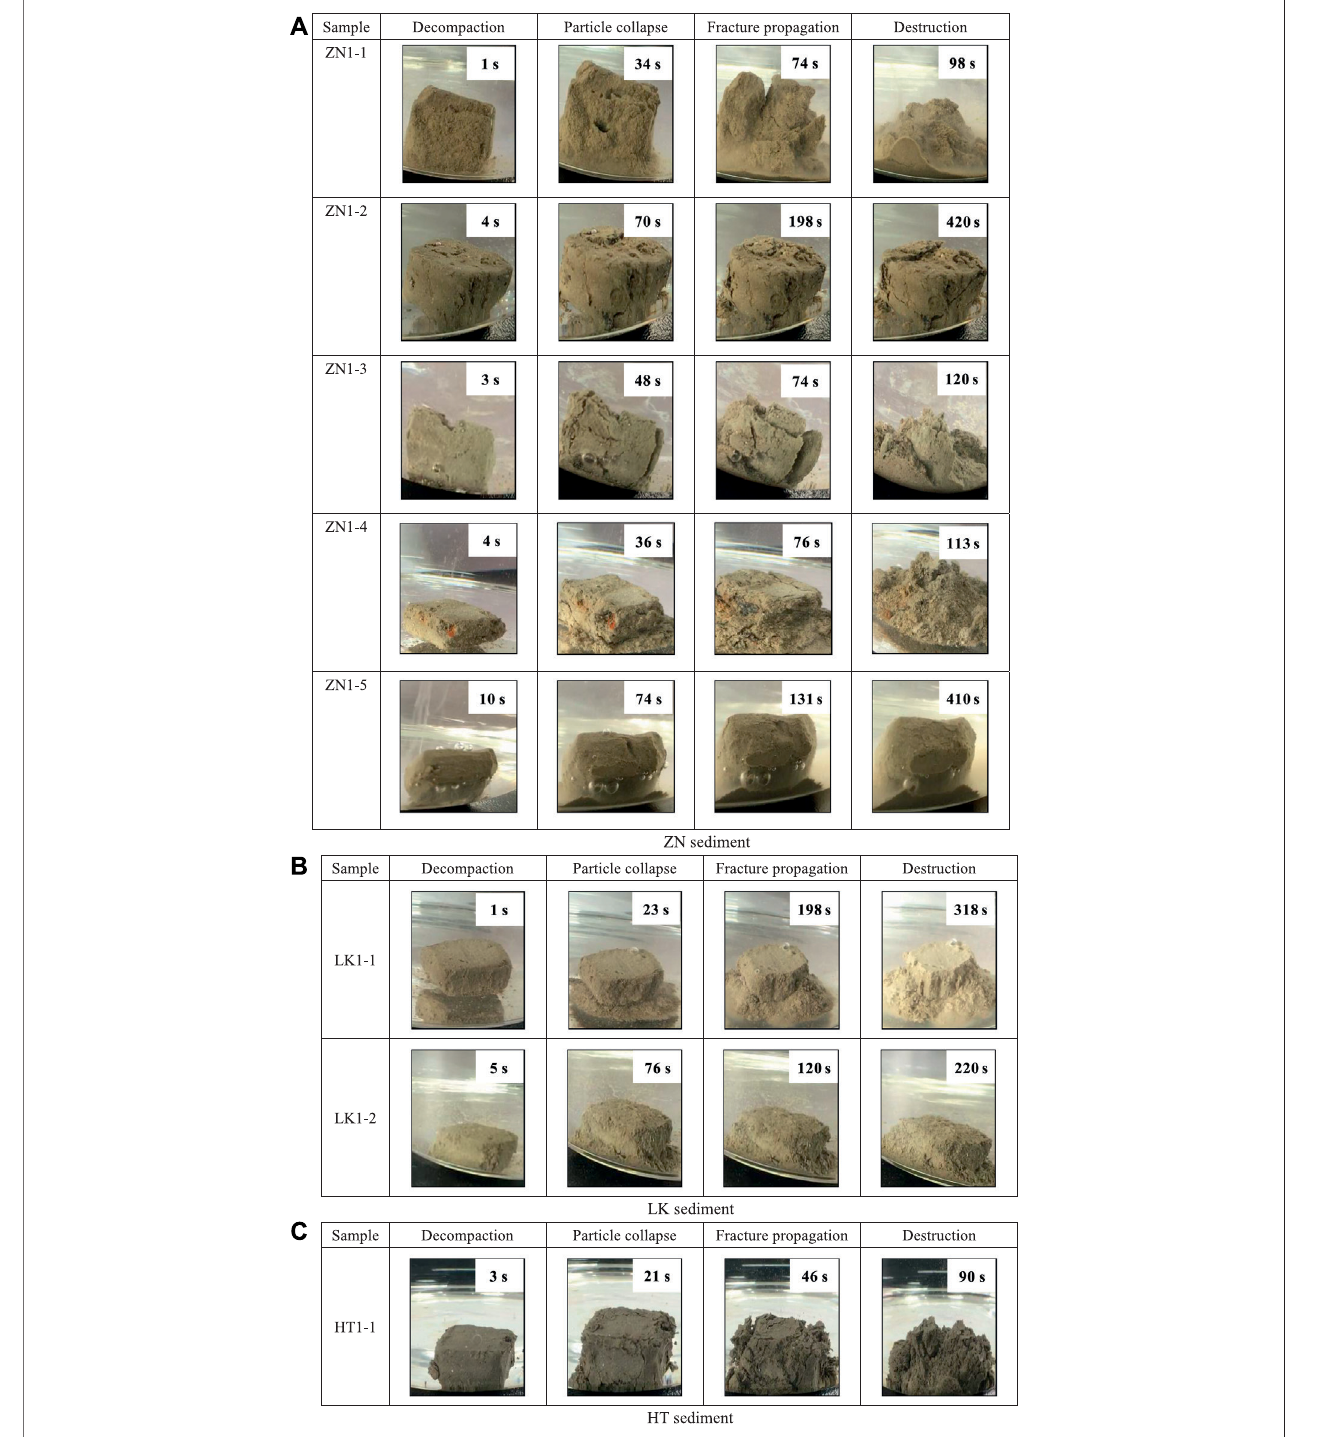
FIGURE 4 | The diagram of disintegration process (A) ZN sediment, (B) LK sediment and (C) HT sediment.